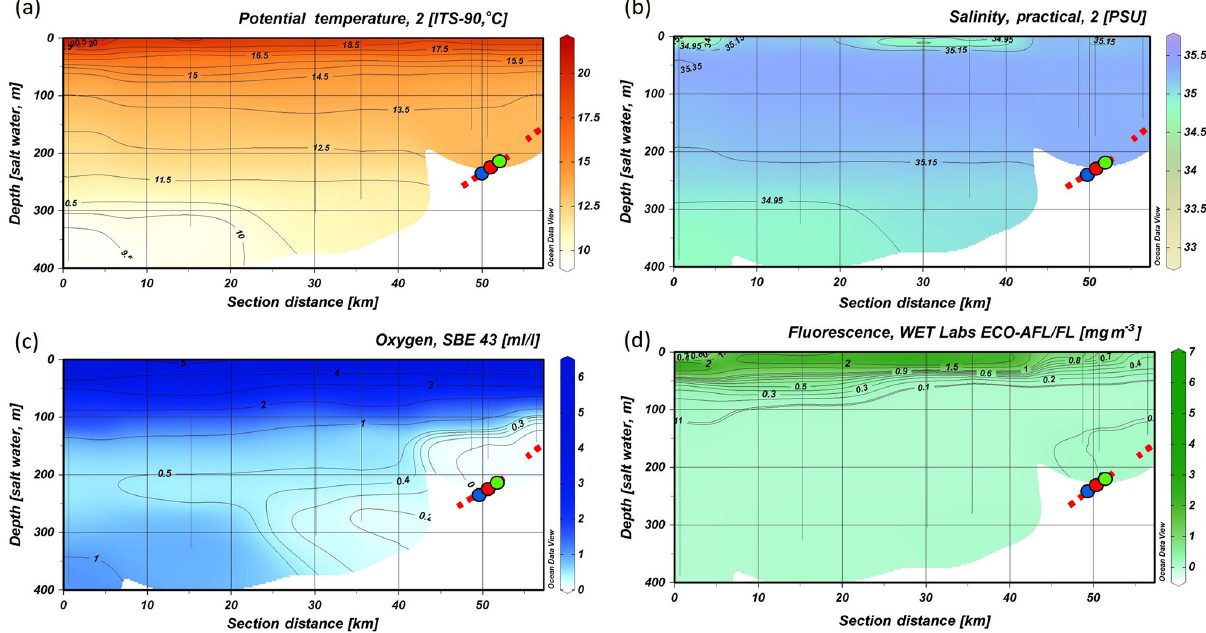
Figure 4. CTD transect across the Namibian margin (see Fig. 1b for location). Data are presented for (a) potential temperature ( ◦ C), (b) salin- ity (PSU), (c) dissolved oxygen concentrations (mLL − 1 ), note the pronounced oxygen minimum zone (OMZ) between 100 and 335m water depth, and (d) fluorescence (mgm − 3 ) (data plotted using Ocean Data View v.4.7.8; http://odv.awi.de, last access: 12 February 2016; Schlitzer, 2011). The occurrence of fossil CWC mounds is indicated by a red dashed line, colored dots indicate bottom lander